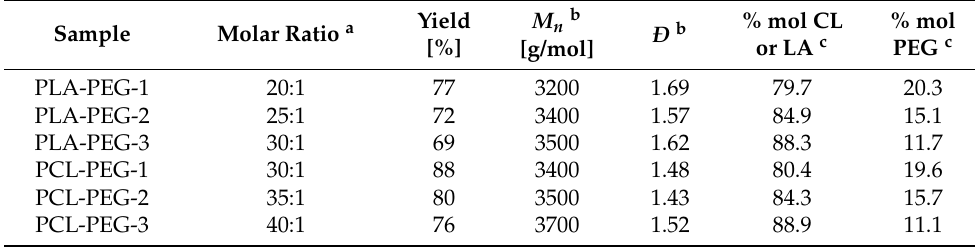
Table 1. Synthesis of CL, rac -LA and PEG